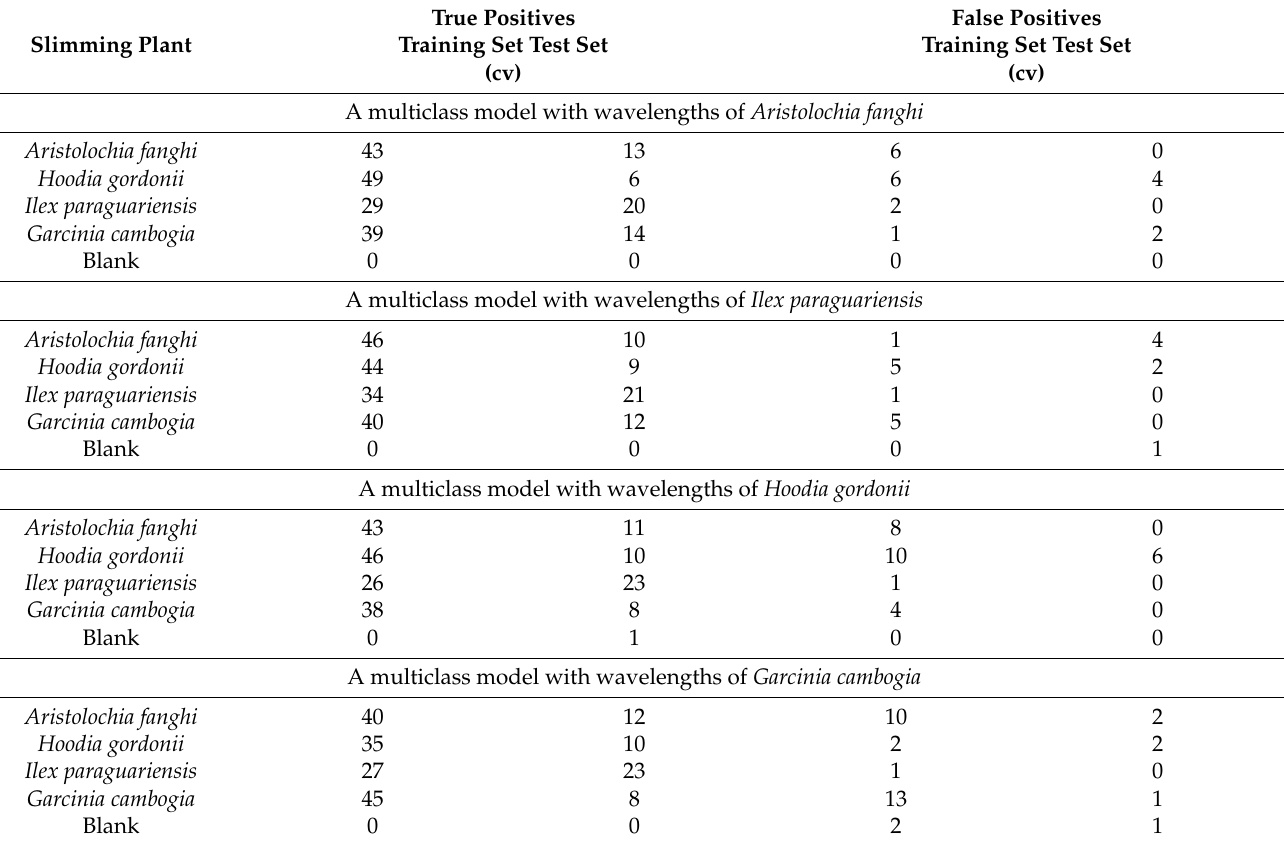
Table 6. The overall depiction of the confusion matrix for multiclass modelling for 4 separate models constructed using the wavelength of that plant. The total sample set comprised 235 samples, and each training and test set formed 176 and 59 samples,